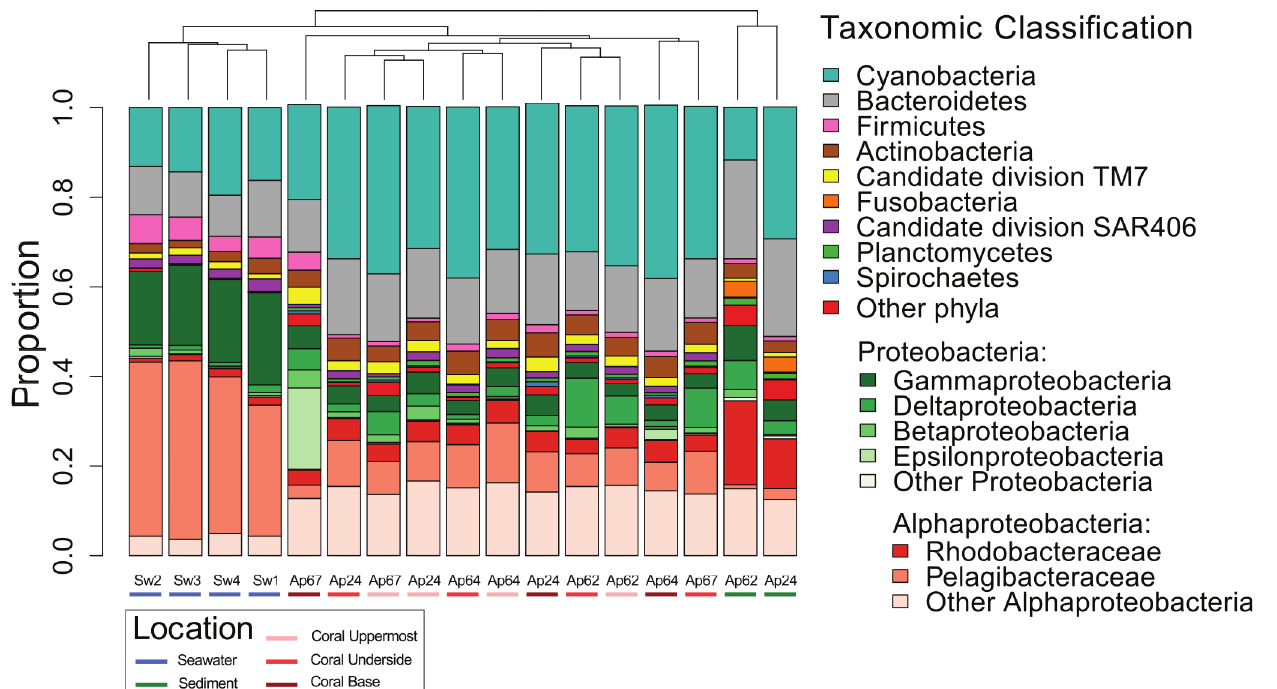
Fig 3. Microbial diversity in different regions of the SML of A . palmata (n = 3 – 4; 11 samples), reef seawater (n = 4), and adjacent sediment (n = 2).